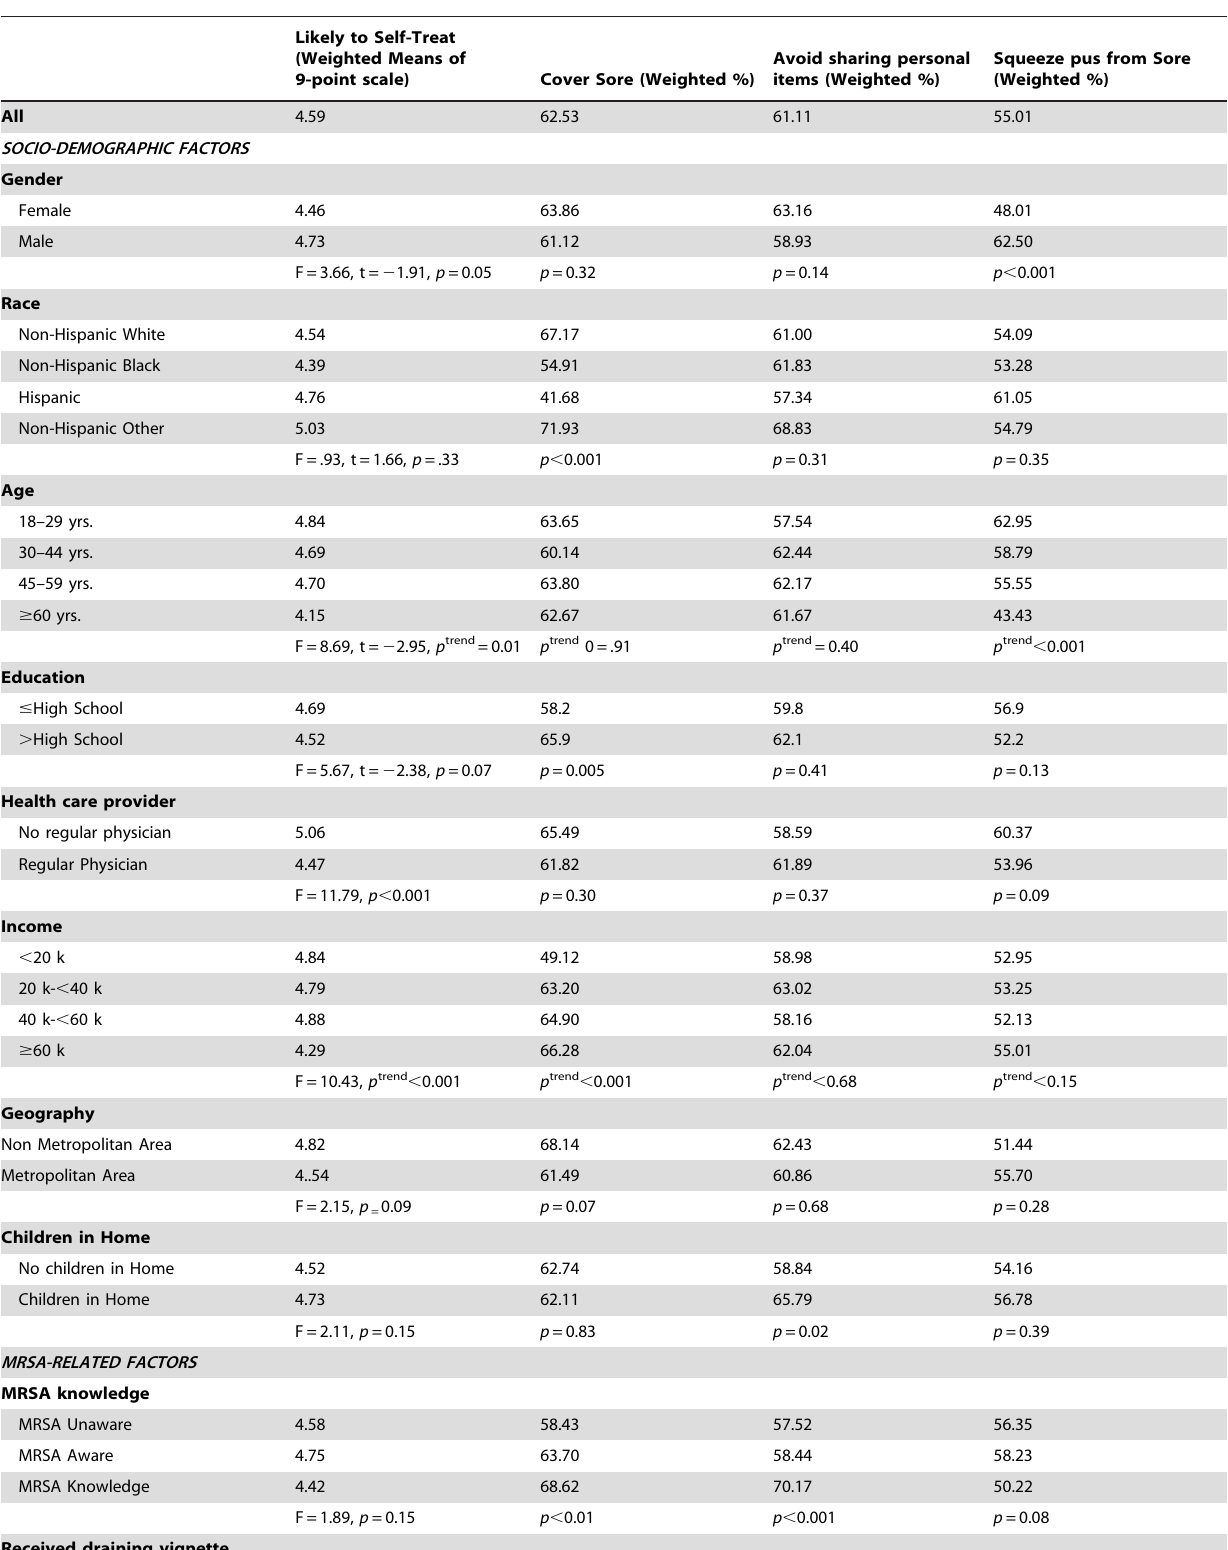
Table 5. Weighted Percentages of Affirmative Reponses to Intention to Self-Treat a MRSA-like Sore and Use of Specific Self Care